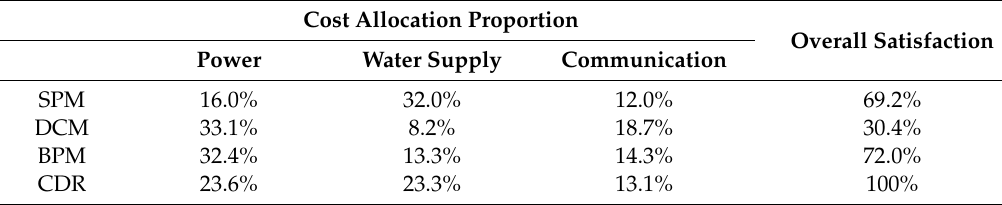
Table 6. Cost allocation proportion and overall satisfaction of pipeline